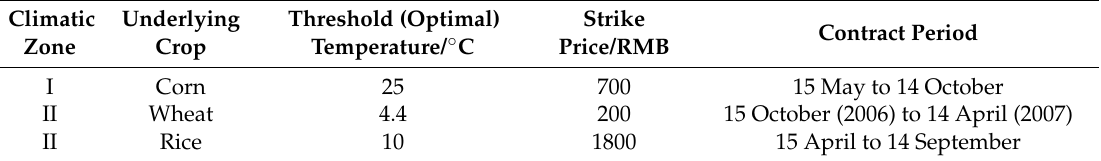
Table 1. Growth degree-day (GDD) call option contract specifications (year: